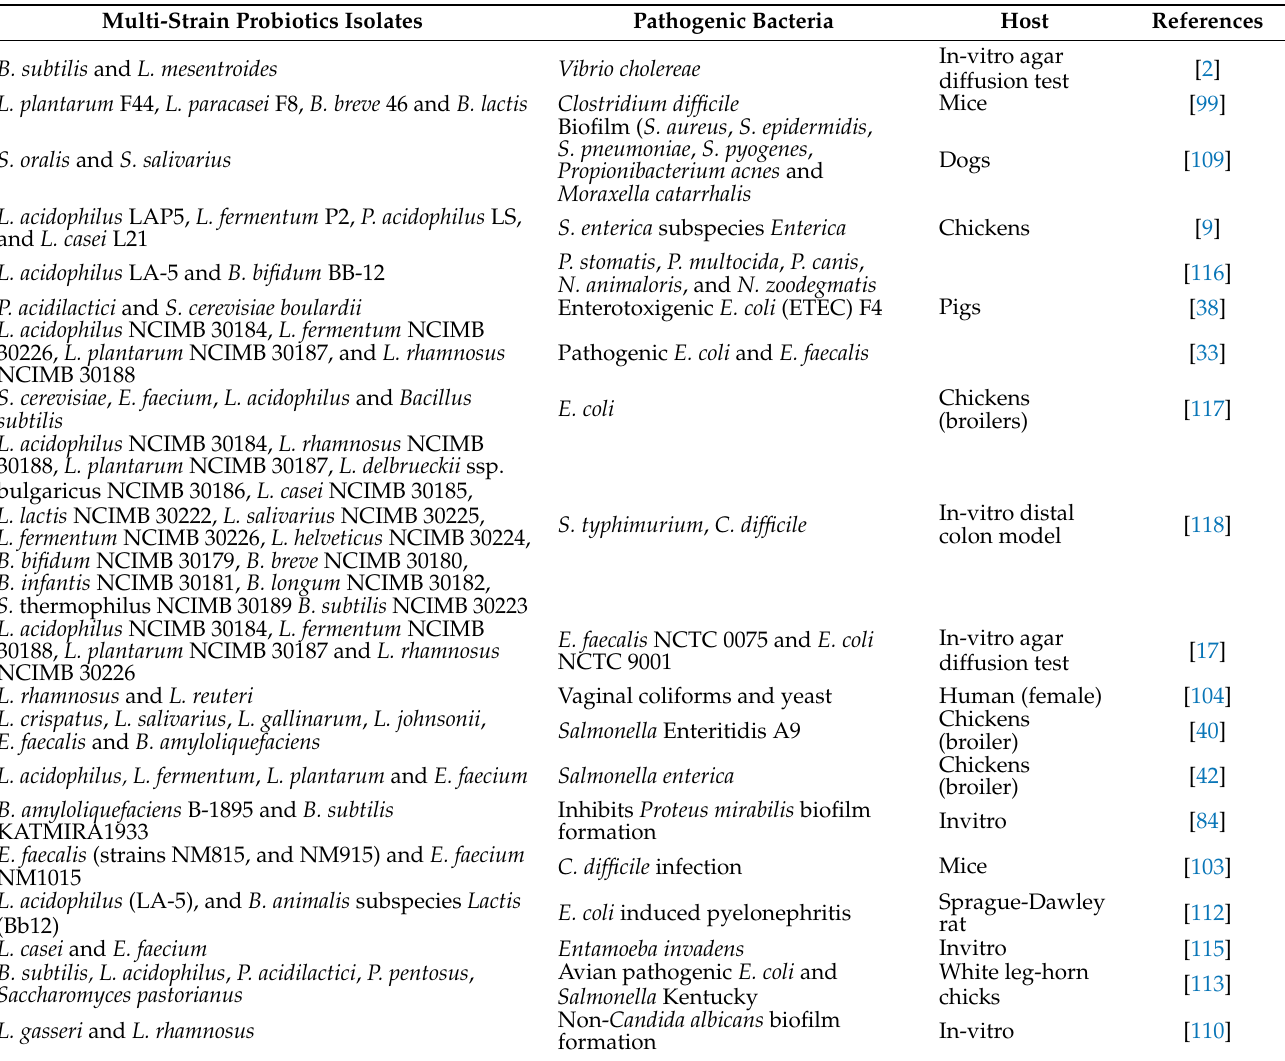
Table 2. Multi-strains probiotics against pathogenic